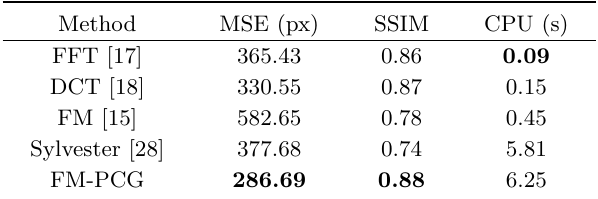
Fig. 13 Application to photometric stereo (PS). (a)–(c) Three images (among 20), of size 1070 × 1070, acquired from the same point of view but under different lightings. After estimating the surface normals by PS, we integrated them by (d) FM, before (e) refining this initial guess by PCG iterations.The full integration process required a few seconds.(f)–(g) MSE (in pixel) of the reprojected images, computed from the surface estimated by (f) FM and (g) FM-PCG. (blue is 0, and red is > 1000).Due to the local nature of FM, radial propagation of errors is visible. After correction by CG, such artefacts are eliminated. Remaining bias is due to shadows. These results are experimentally compared with existing methods in Table 16. Table 16 Results on the PS dataset. Our method (initialisation by FM, then refinement by PCG from this initial guess) provides the most accurate results. We show the CPU time, as well as the mean MSE and SSIM for the 20 reprojected